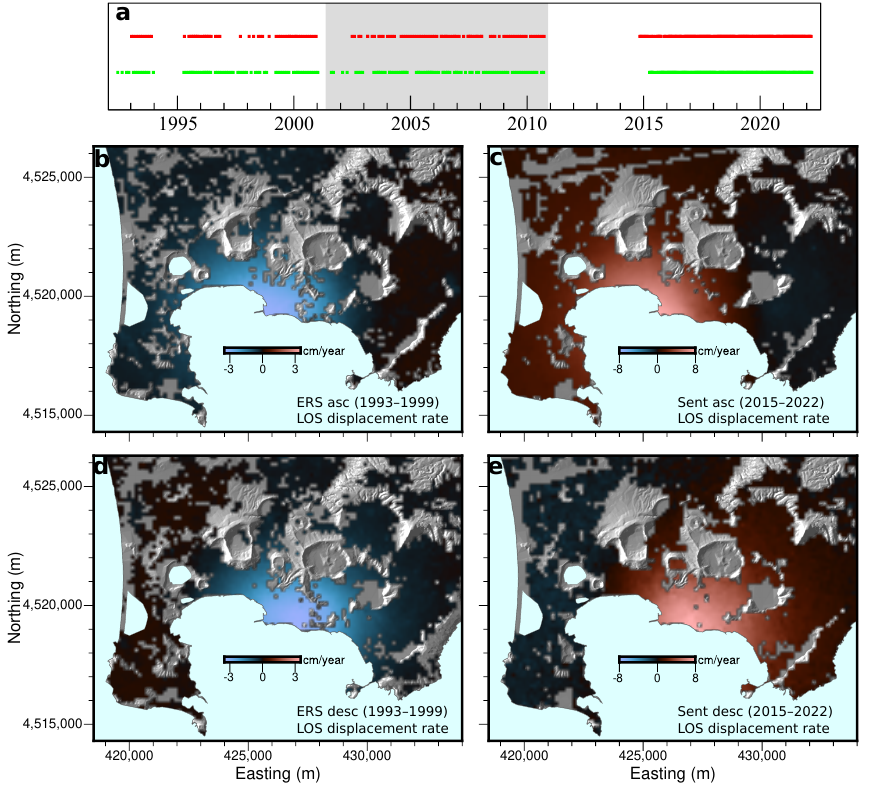
Figure 3. Time series of SAR LOS displacements. ( a ) Red and green squares, acquisition dates of the ascending- and descending-orbit images; only those out of the grey rectangle are used in this work. ( b ) Mean LOS displacement rate during 1993–1999, ERS/ENVISAT ascending orbit. ( c ) Mean LOS displacement rate during 2015–2022, Sentinel-1A ascending orbit. ( d ) Mean LOS displacement rate during 1993–1999, ERS/ENVISAT descending orbit. ( e ) Mean LOS displacement rate during 2015–2022, Sentinel-1A descending